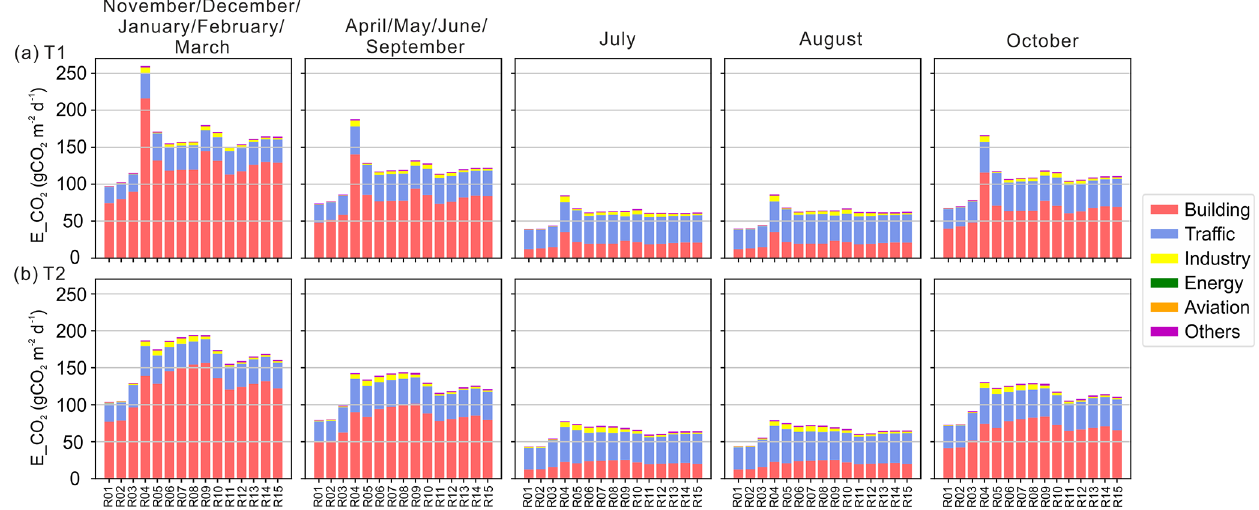
Figure 3. Averaged anthropogenic CO 2 fluxes along each GreenLITE ™ chord according to the AIRPARIF inventory.